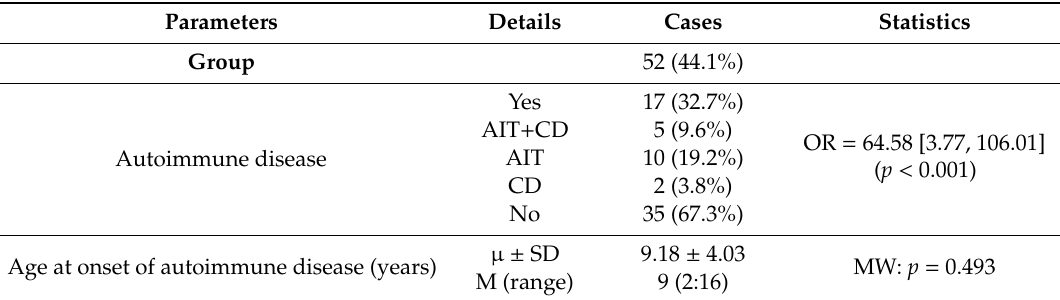
Table 6. Autoimmune diseases in diabetic patients.